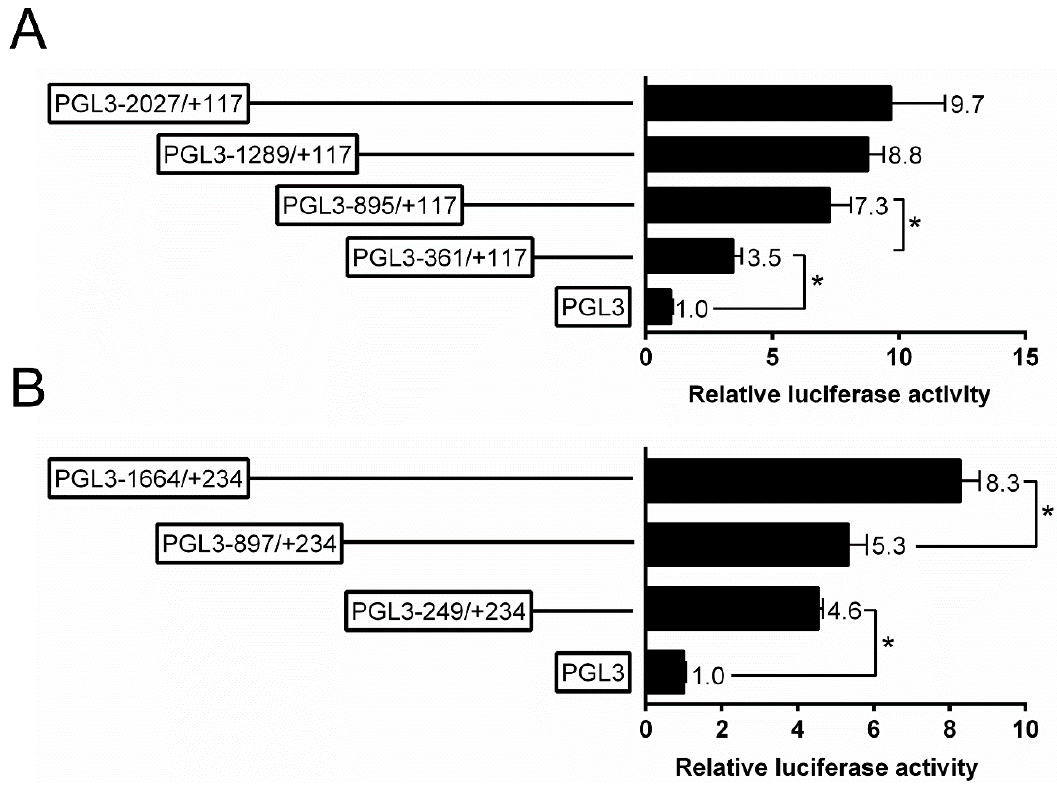
Figure 2. 5 ′ unidirectional deletion assays of the promoter regions of ZIP3 ( A ) and ZIP8 ( B ) of yellow catfish. Values mean the ratio of activities of Firefly to Renilla luciferase, normalized to the control plasmid, and are shown as mean ± standard error of mean (SEM) ( n = 3). Asterisk (*) means significant differences between two groups ( p < 0.05).